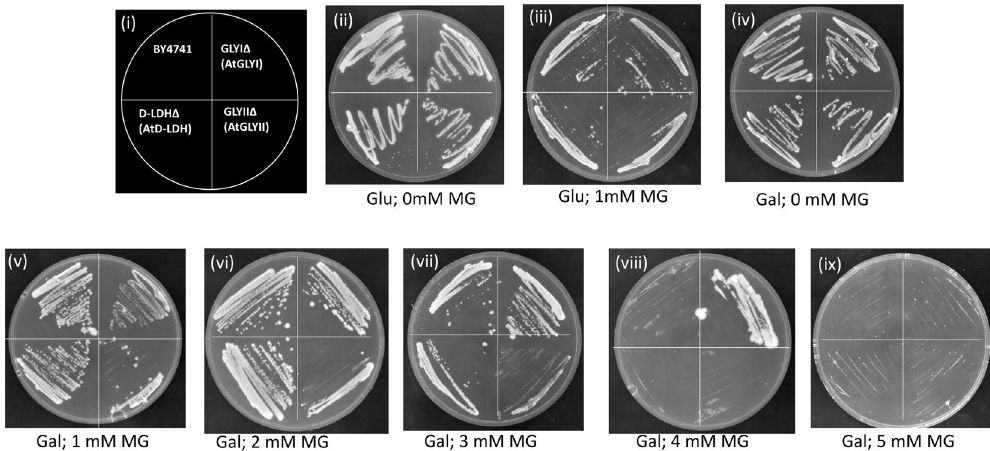
Figure 7. Functional complementation of MG detoxification genes in respective yeast mutant confirms the contribution of different genes in MG detoxification: Yeast cells mutant of GLYI, GLYII and D-DLH were transformed with pYES2-AtGLYI, pYES2-AtGLYII and pYES2-AtD-LDH respectively and were grown in Ura − SD solid media with different supplements to check for their contribution to MG detoxification. Wild type BY4741 cells containing empty vector pYES2 were used for comparison. ( i ) Pictorial representation of various strains used. ( ii ) Medium supplemented with 20% glucose. ( iii ) medium supplemented with 20% glucose and 1 mM MG. ( iv ) Medium supplemented with 20% galactose; ( v ) Medium supplemented with 20% galactose and 1 mM MG. ( vi ) Medium supplemented with 20% galactose and 2 mM MG. ( vii ) Medium supplemented with 20% galactose and 3 mM MG. ( viii ) Medium supplemented with 20% galactose and 4 mM MG. ( ix ) Medium supplemented with 20% galactose and 5 mM